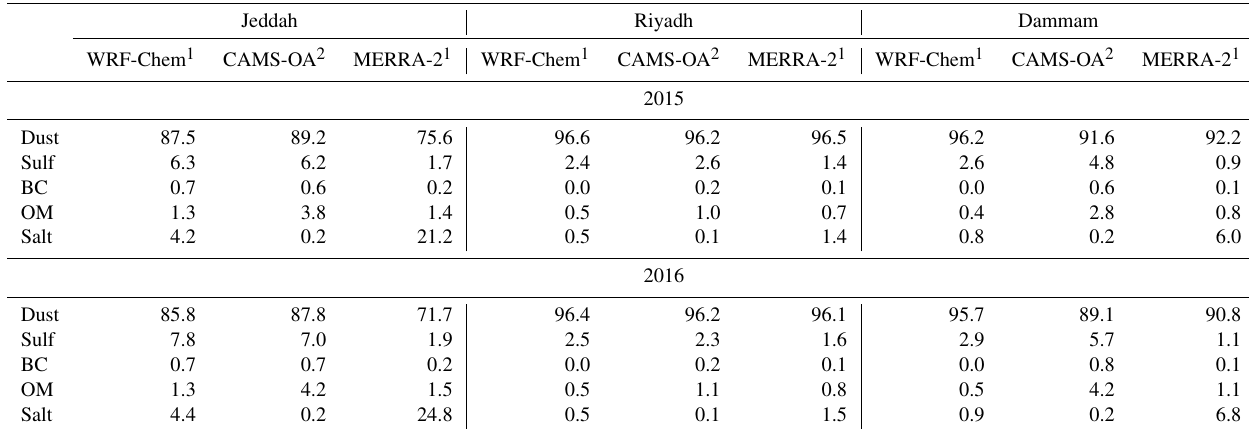
Table 7. Contributions (%) of dust and nondust components to PM 10 for Jeddah, Riyadh, and Dammam during 2015–2016. Jeddah